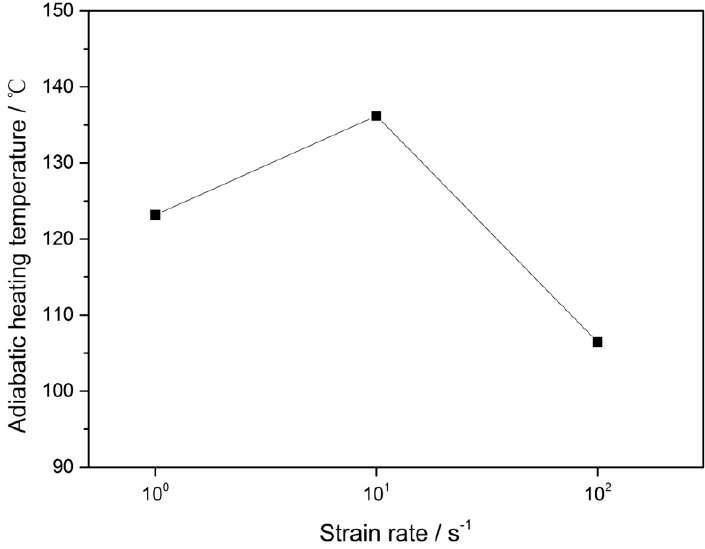
Figure 9. The adiabatic temperature rise of Fe–30Mn–9Al–1C steel deformed at strain rates of 10 0 –10 2 s − 1